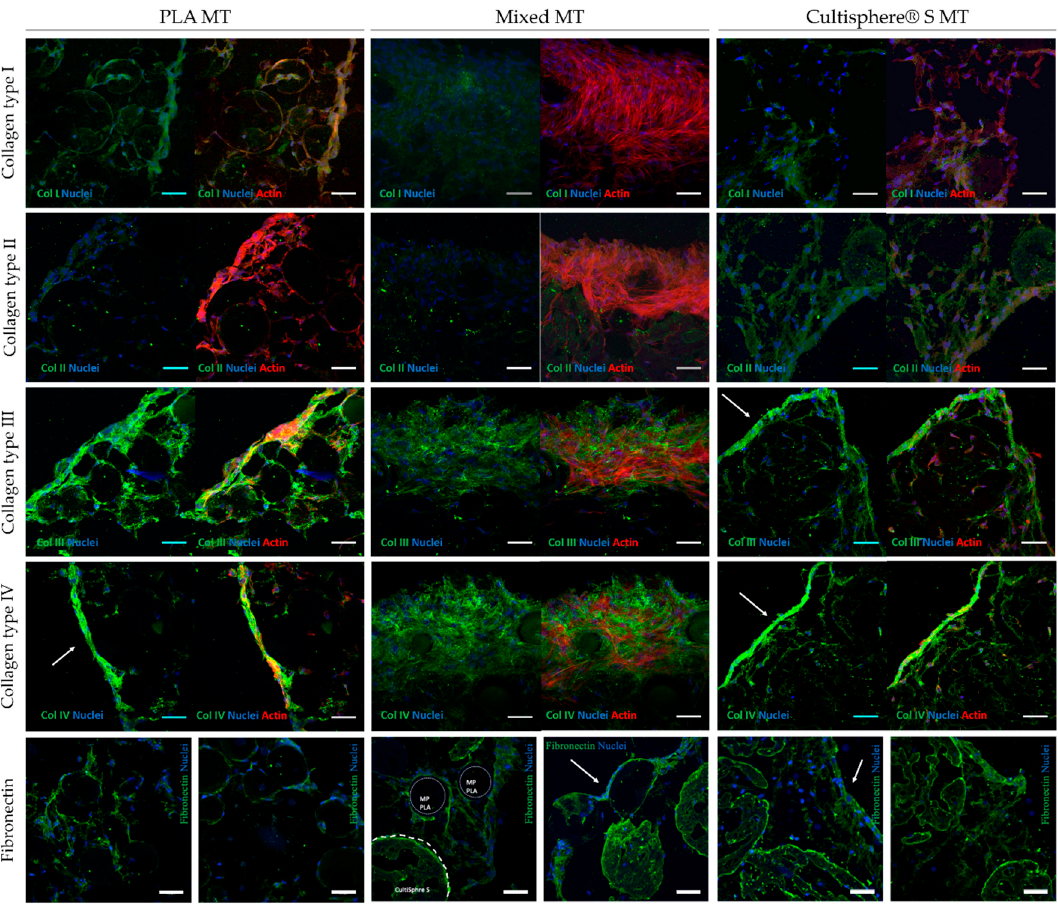
Figure 6. Immunofluorescence staining of sliced MTs for collagen types I, II, III, IV, and fibronectin (green), actin (red), and nuclei (blue), scale bars = 100 μ m. The arrowheads point to protein localization.